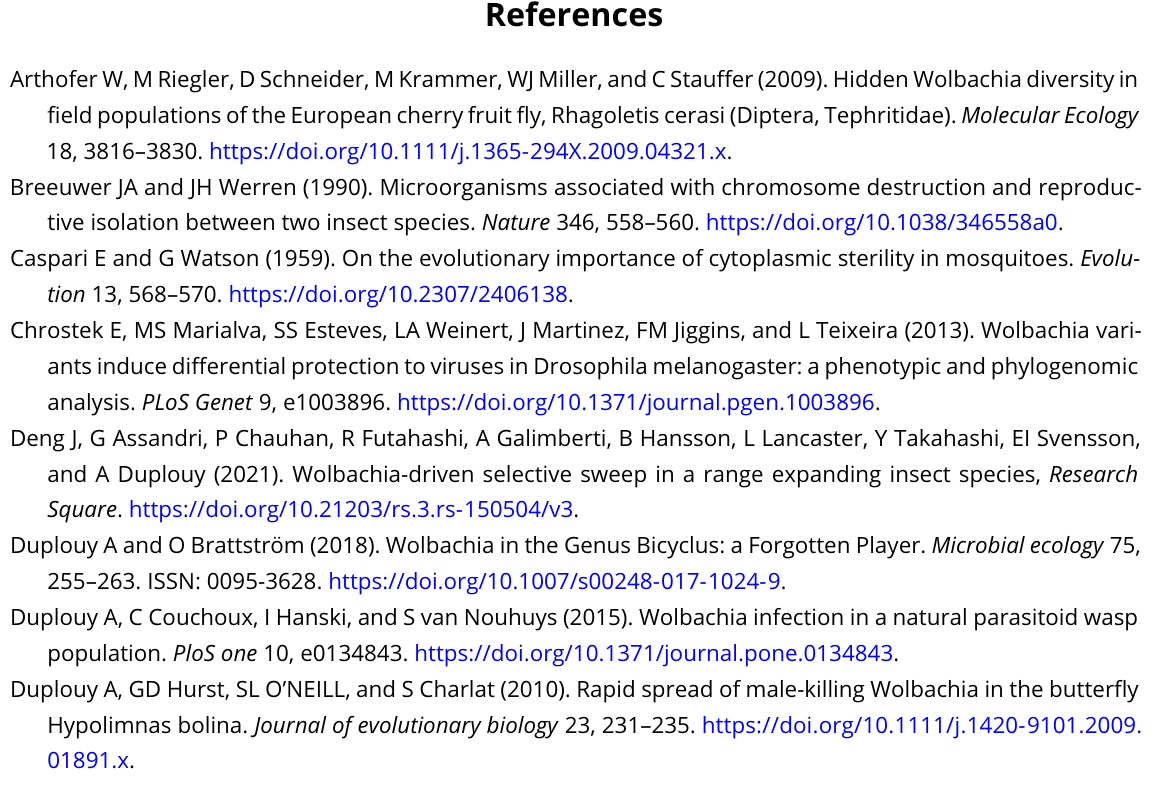
ˆ p F ˆ p M is never less